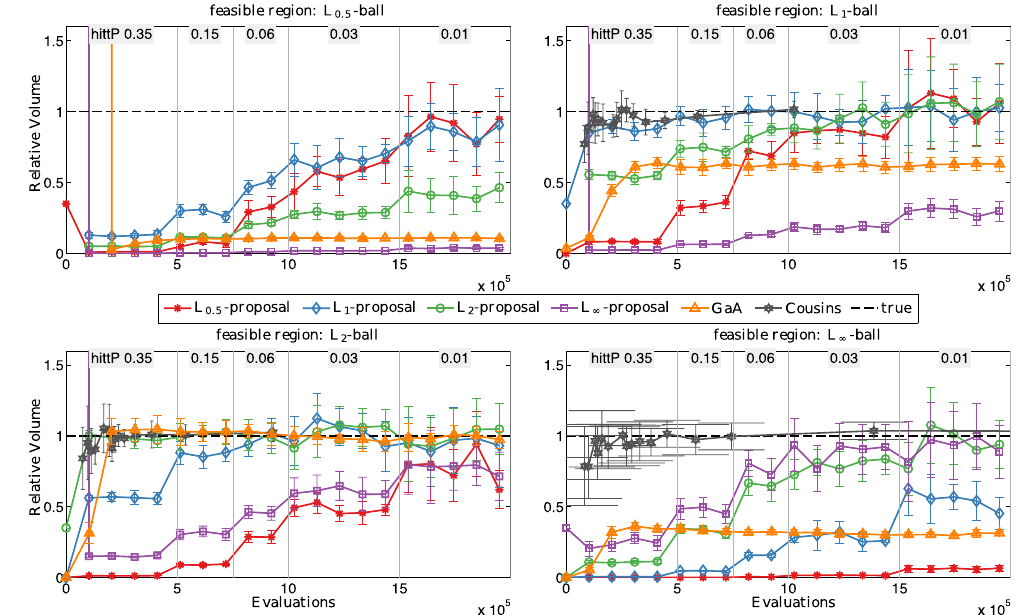
Figure 5. Average and standard deviation (over ten independent runs) of the normalized volume (estimated volume/true volume) of anisotropic 20-dimensional L p -balls ( p = 0.5, 1, 2, ∞ ) approximated with proposal distributions of different p . The results are shown for decreasing target hitting probability, starting from the default initialization 0.35, as indicated at the top of each plot. The dashed line shows the true volume. For comparison, we also show the results obtained with Gaussian Adaptation 36 and Cousins’ convex volume estimator 17